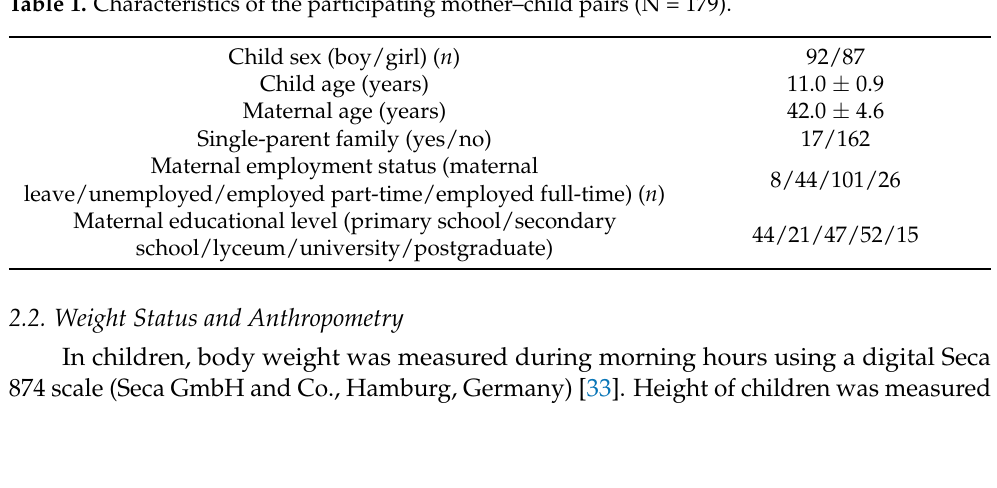
Table 1. Characteristics of the participating mother–child pairs (N =